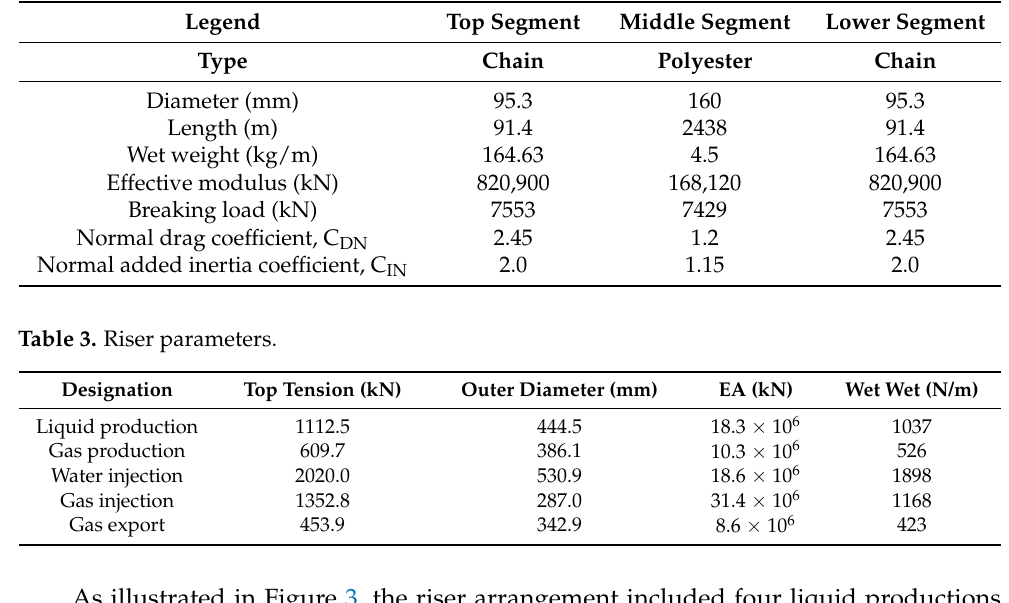
Figure 3. FPSO–mooring–riser layout. Table 2. Mooring line details [43].